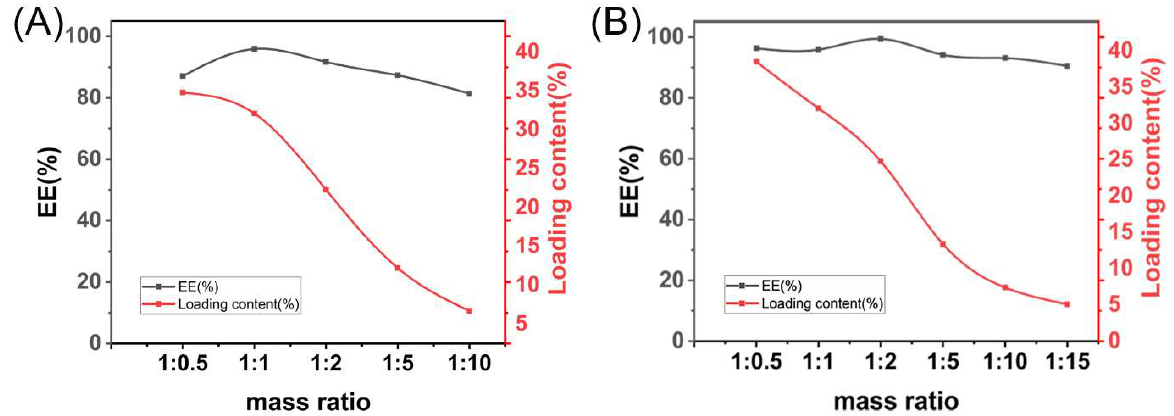
Figure 1. Formulation screening results. ( A ) The ratio of GA to Soluplus ® was fixed at 1:1 ( w / w ), and the ratio of L-Arg was changed. The mass ratio indicates the ratio of GA to L-Arg ( w / w ). ( B ) In the screening results shown in ( A ), the optimal ratio of GA to L-Arg was 1:1 ( w / w ), and based on this result, the ratio of Soluplus ® was changed; the mass ratio indicates the ratio of GA to Soluplus ® ( w / w ).